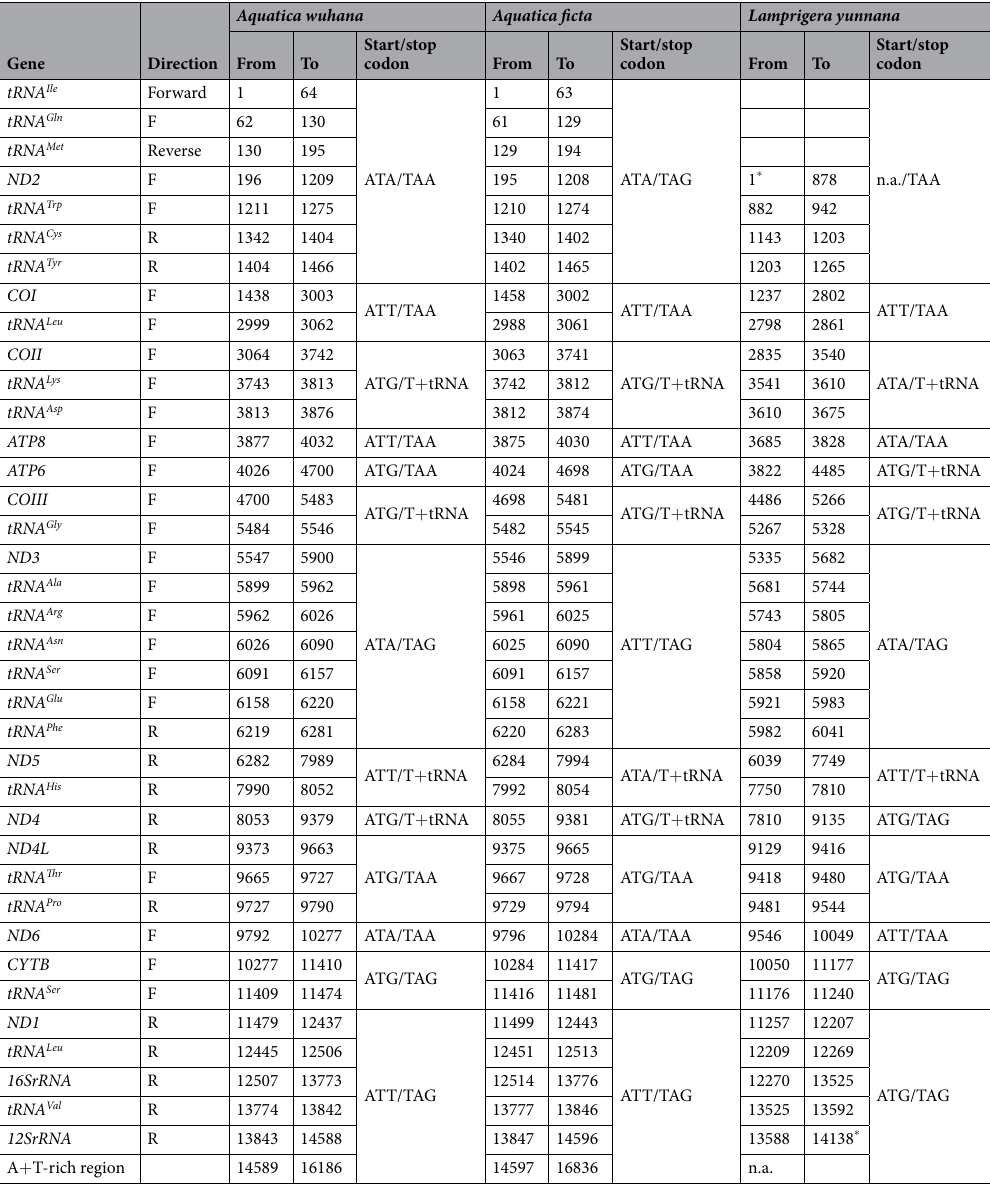
Table 3. Annotations of the three newly sequenced mitochondrial genomes. Incomplete sequenced region was indicated with an asterisk. Abbreviation: n.a., not available (due to incomplete